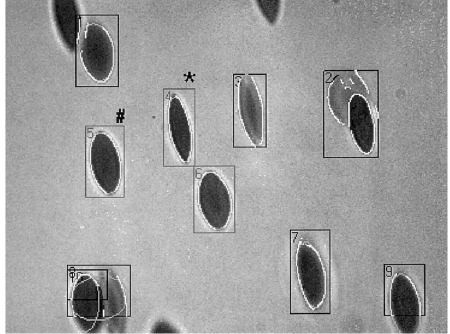
Fig. 2. Images of RBCs in a shear °ow, obtained with the help of a microscope.